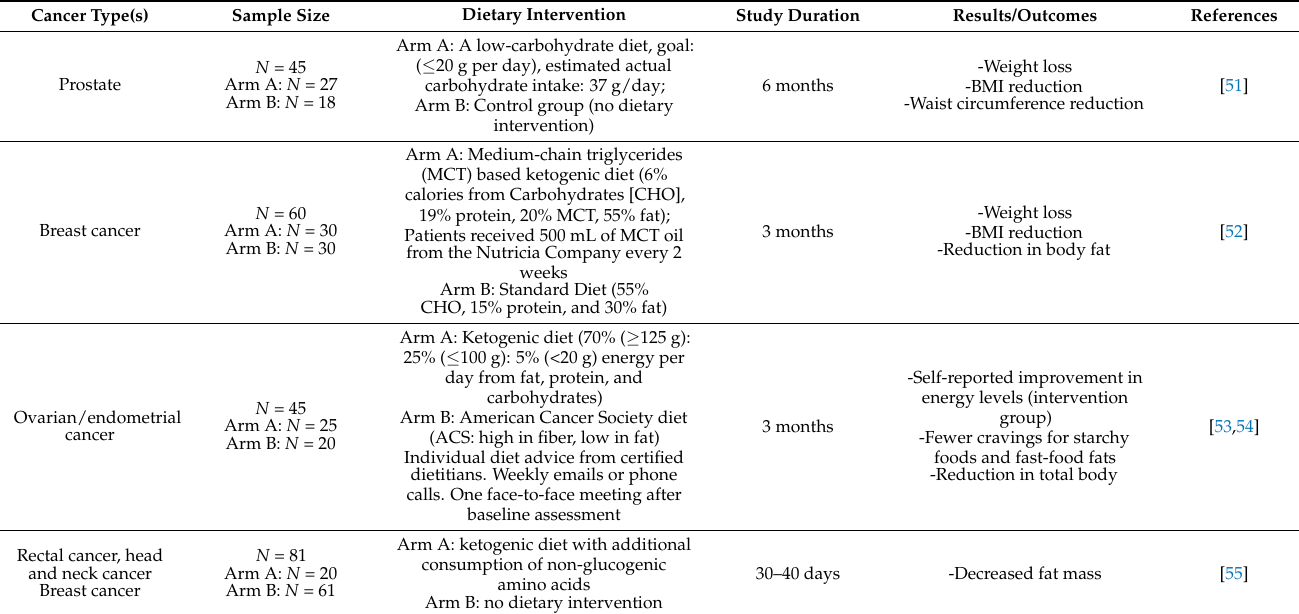
Table 1. Summary of Clinical Studies of KD and